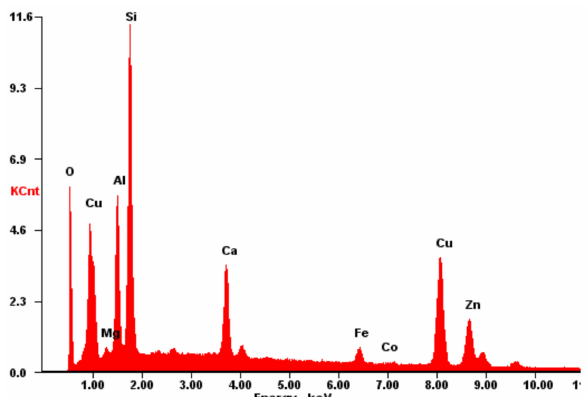
Figure 22. Exemplary EDS spectrum registered for a fragment of a textolite material with sediment made of copper compounds and very strong degradation effects. Copper was present from the sediment layer, along with elements from the glass